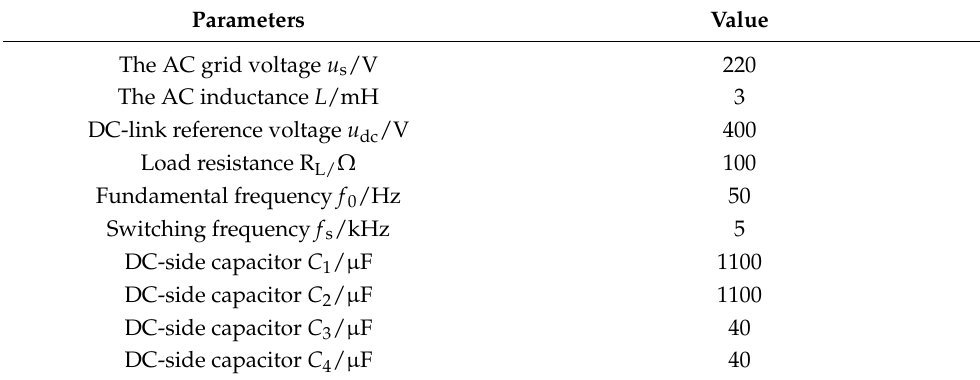
Table 3. System parameters.